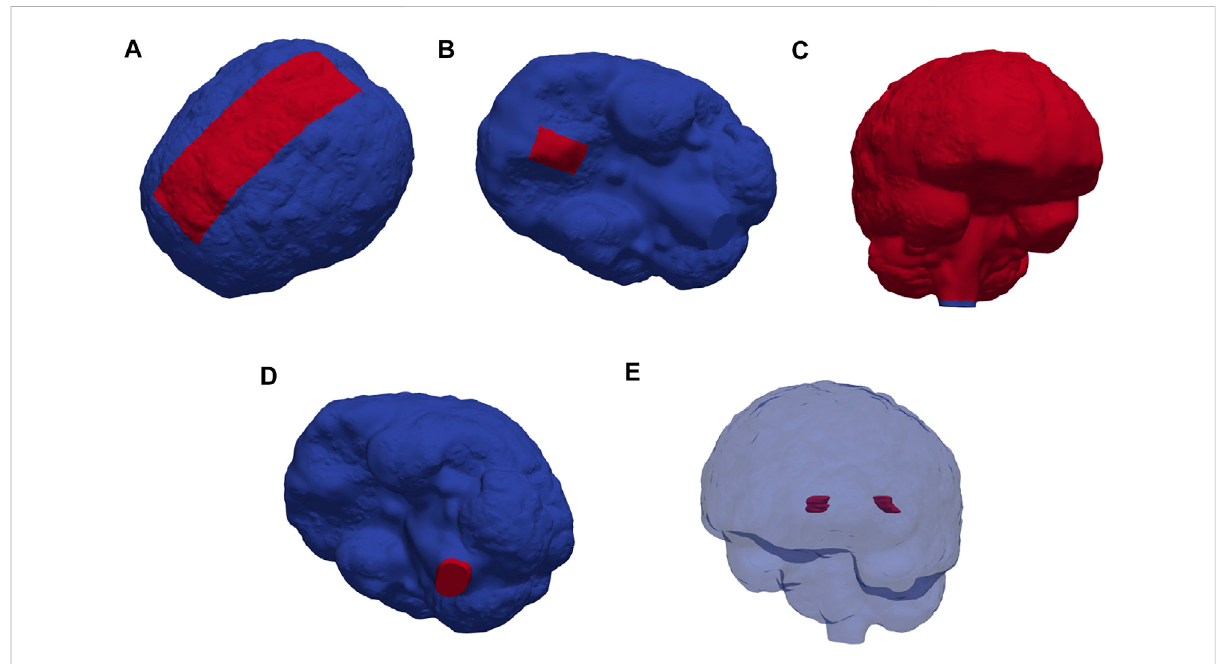
FIGURE 2 Red markers highlight important subregions and boundaries in the computational domain: the (A) parasagittal dura, (B) cribriform plate, (C) meningeal lymphatics, (D) foramen magnum, and (E) choroid